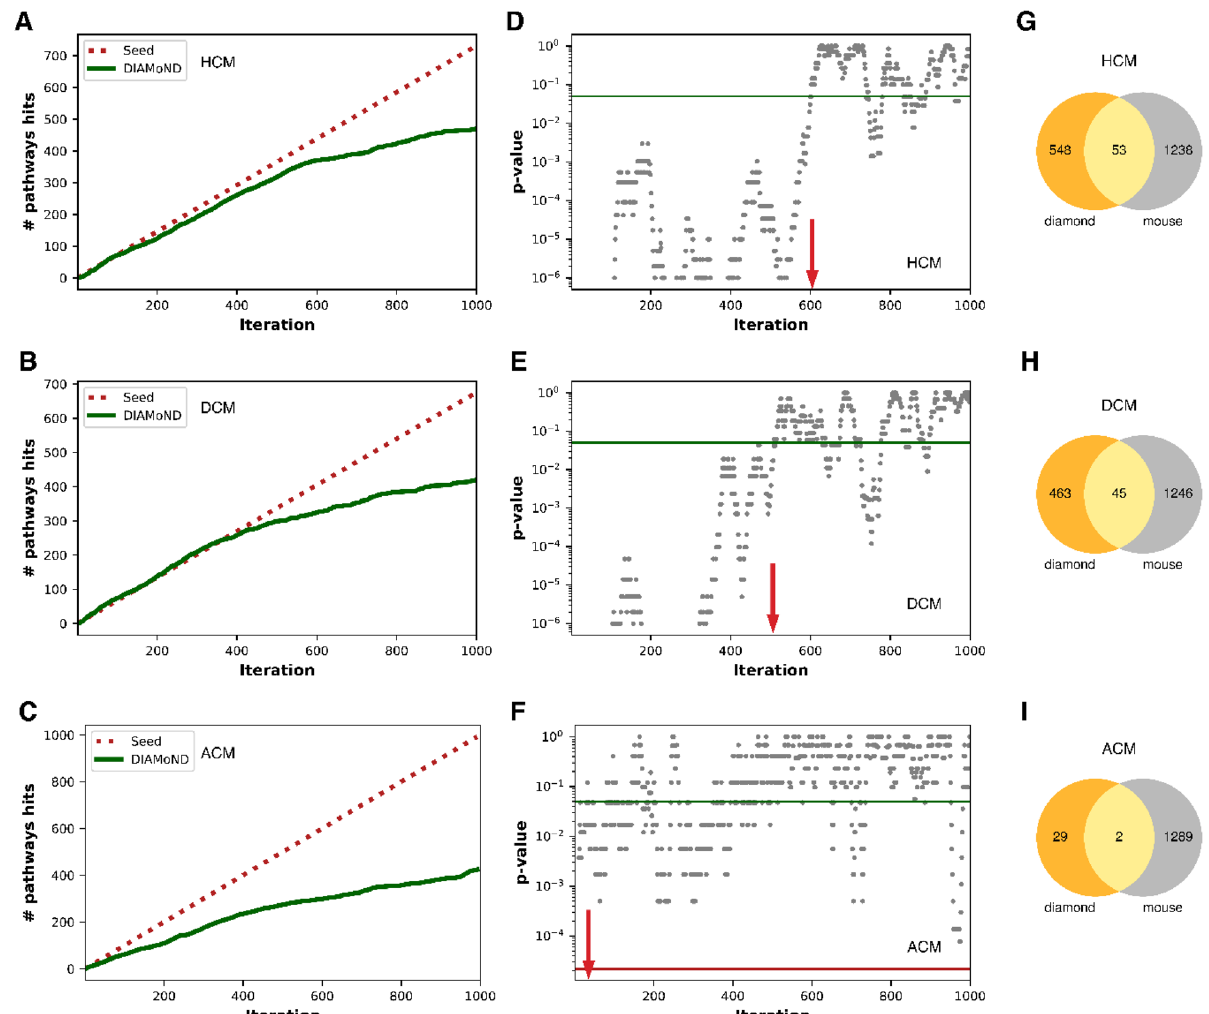
Figure 4. Candidate genes: Graph illustration of the biologically relevant association of the predicted DIAMOnD genes and screening based on abnormal heart phenotype in the mouse. ( A , B , C ) Panels correspond to true molecular pathways hits of DIAMOnD genes of hypertrophic cardiomyopathy ( A ), dilated cardiomyopathy ( B ), and arrhythmogenic cardiomyopathy ( C ), respectively (red lines, seed genes; green lines, DIAMOnD genes). ( D , E , F ) Panels show the distribution of p -value for DIAMOnD genes where a sliding window of DIAMOnD genes size equal to seed genes was used for Fisher’s test for each iteration. The cut-off of p -value = 0.05 (green line) was chosen for selecting DIAMOnD genes in each cardiomyopathy. Red arrow marks the boundary of reliable DIAMOnD genes ( G , H , I ) Panels are Venn diagrams that project the overlap of DIAMOnD genes and mouse genes showing abnormal heart